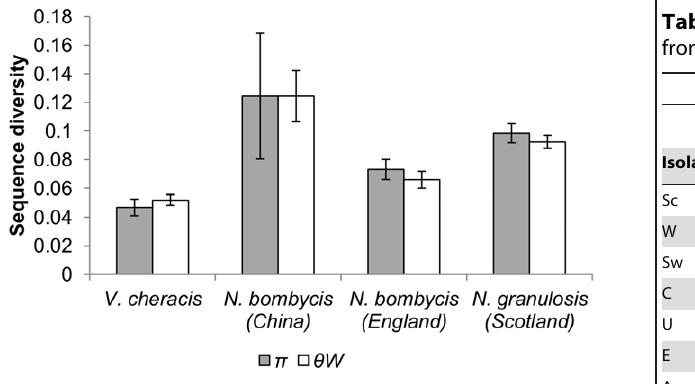
Figure 3. Nucleotide diversity of the ITS and flanking 18S and 16S rDNA regions of N.bombycis , N.granulosis and V.cheracis isolates. Nucleotide diversity is calculated as the average heterozy- gosity per site ( p ) and the average number of nucleotide differences per site ( h W ). Error bars show the standard error for each isolate.